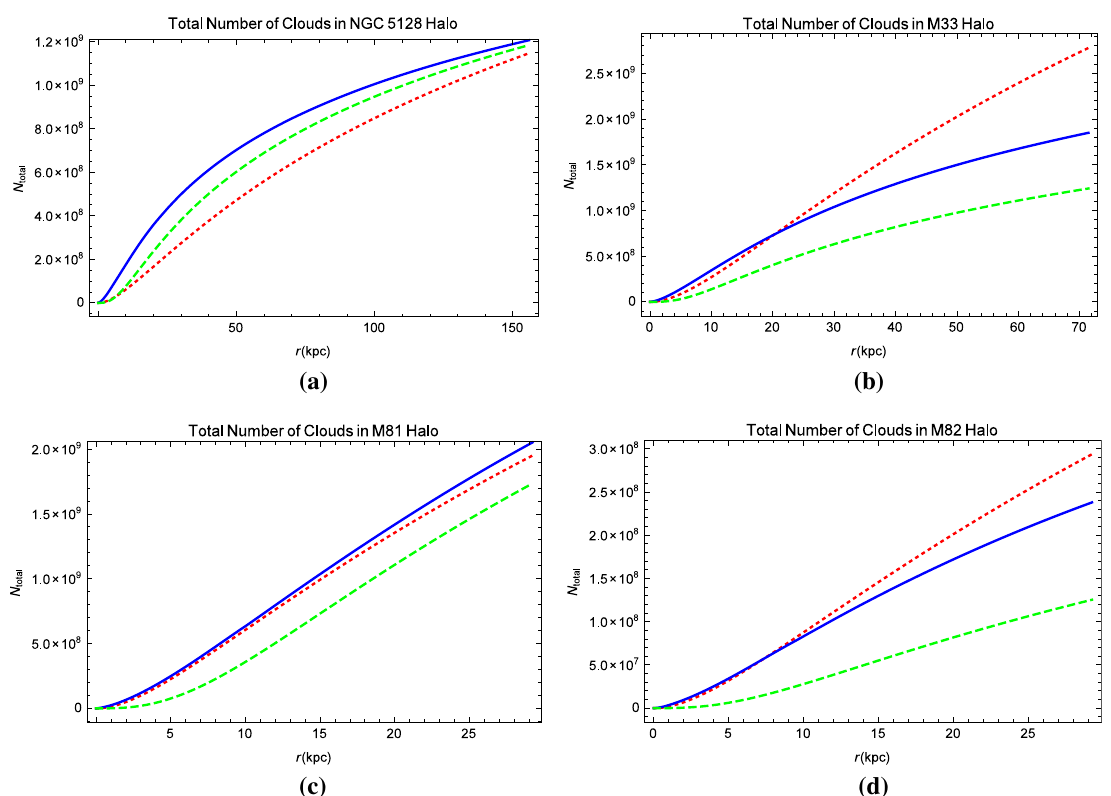
Fig. 1 The curves in the figure represent the total number of gas clouds in the galactic halo, with the assumption that the total halo of the galaxy is composed of these clouds, i.e., f = 1. The red-dotted, blue-bold, and green-dashed represent N total for NFW, Moore and Burkert models. a Gives the total number of gas clouds in NGC 5128 within 150 kpc; b gives the total number of gas clouds in M33 within 70 kpc; c gives the total number of gas clouds in M81 within 25 kpc; and d gives the total number of gas clouds in M82 within 25